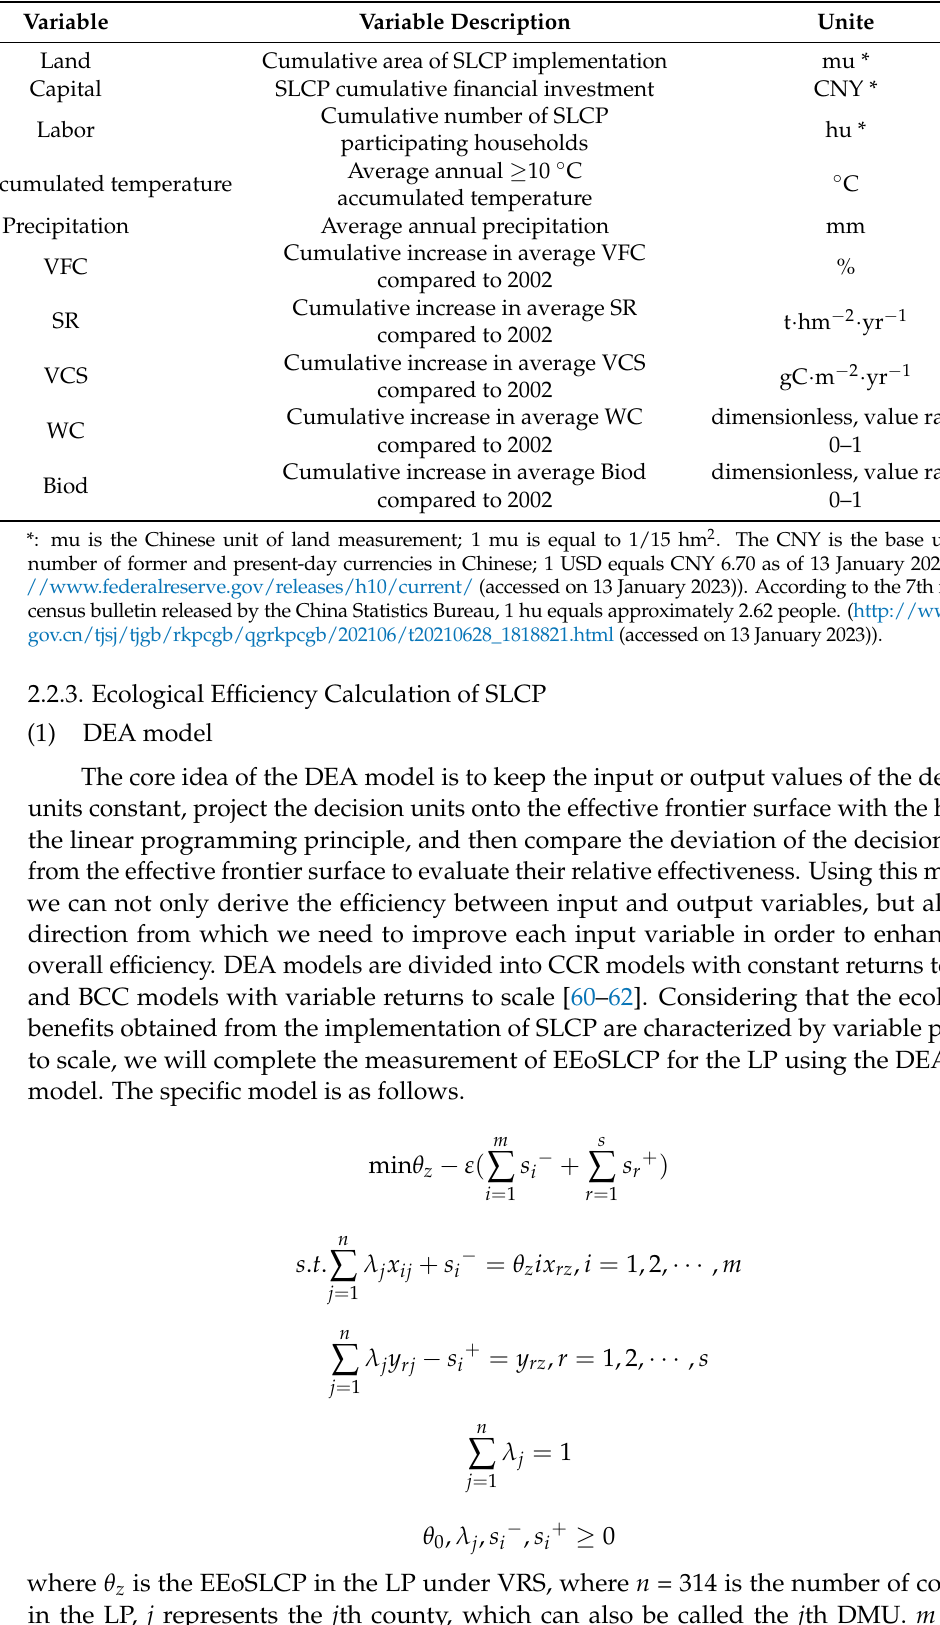
Table 1. Input and output indicators of